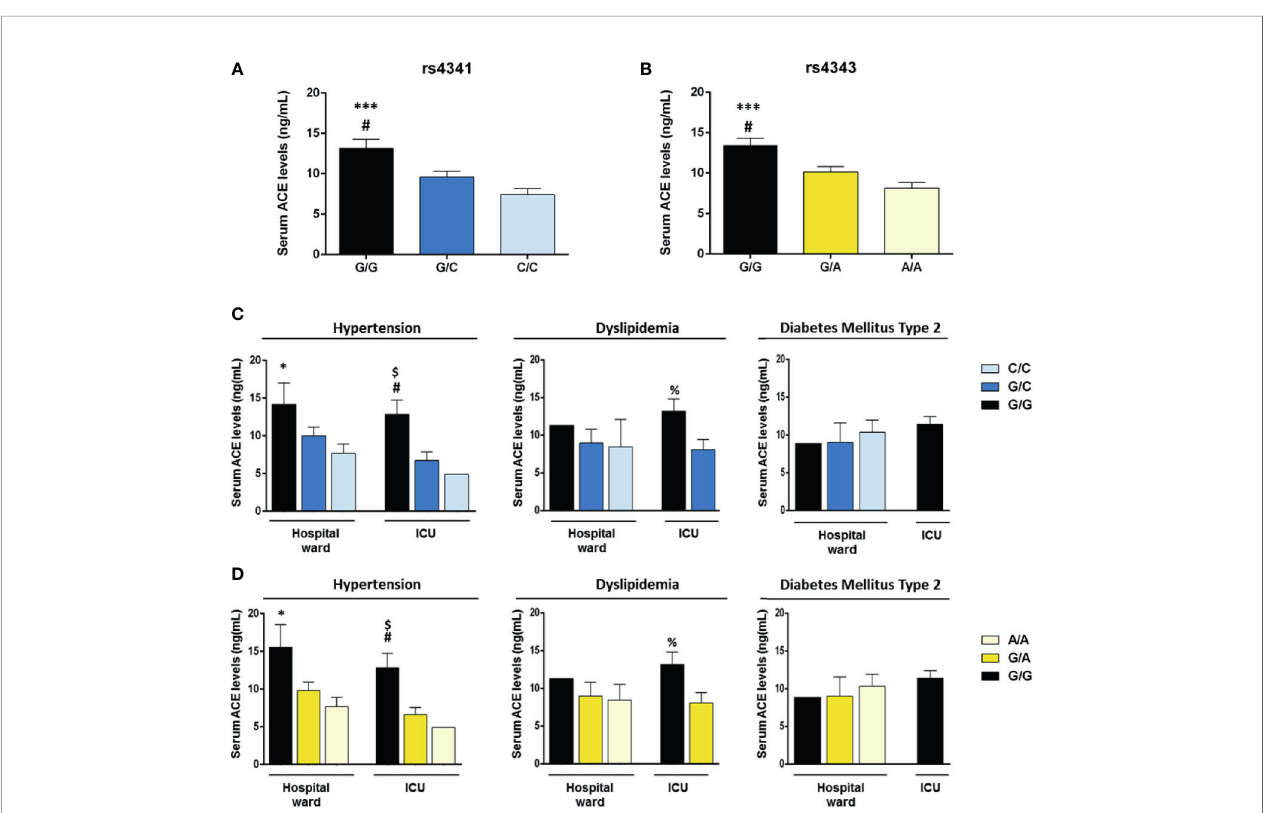
FIGURE 5 | Serum ACE levels of COVID-19 patients according to the genotypes of the rs4341 and rs4343 polymorphisms of ACE. Mean serum ACE levels of COVID-19 patients with different rs4341 (A) and rs4343 (B) genotypes. # p < 0.05 vs G/C group; *** p < 0.001 vs C/C group. (C) Mean serum ACE levels according to the genotypes of the rs4341 polymorphism in COVID-19 patients with hypertension, dyslipidemia or diabetes hospitalized in the ward or in the ICU. * p < 0.05 vs Hospital ward C/C group; # p < 0.05 vs ICU G/C group; $ p = 0.059 vs ICU C/C group; % p = 0.07 vs ICU G/C group. (D) Mean serum ACE levels according to the genotypes of the rs4343 polymorphism in COVID-19 patients with hypertension, dyslipidemia or diabetes hospitalized in the ward or in the ICU. * p < 0.05 vs Hospital ward A/A group; # p < 0.05 vs ICU G/A group; $ p = 0.059 vs ICU A/A group, % p = 0.07 vs ICU G/A group. Data are presented as mean ± standard